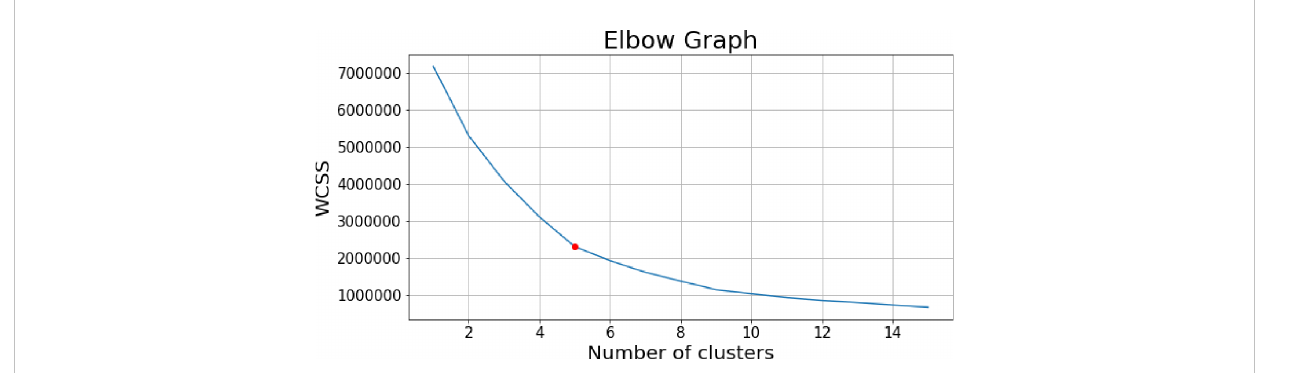
FIGURE 9 Elbow point graph of within-cluster sum of squares, the red point shows the selected number of clusters.